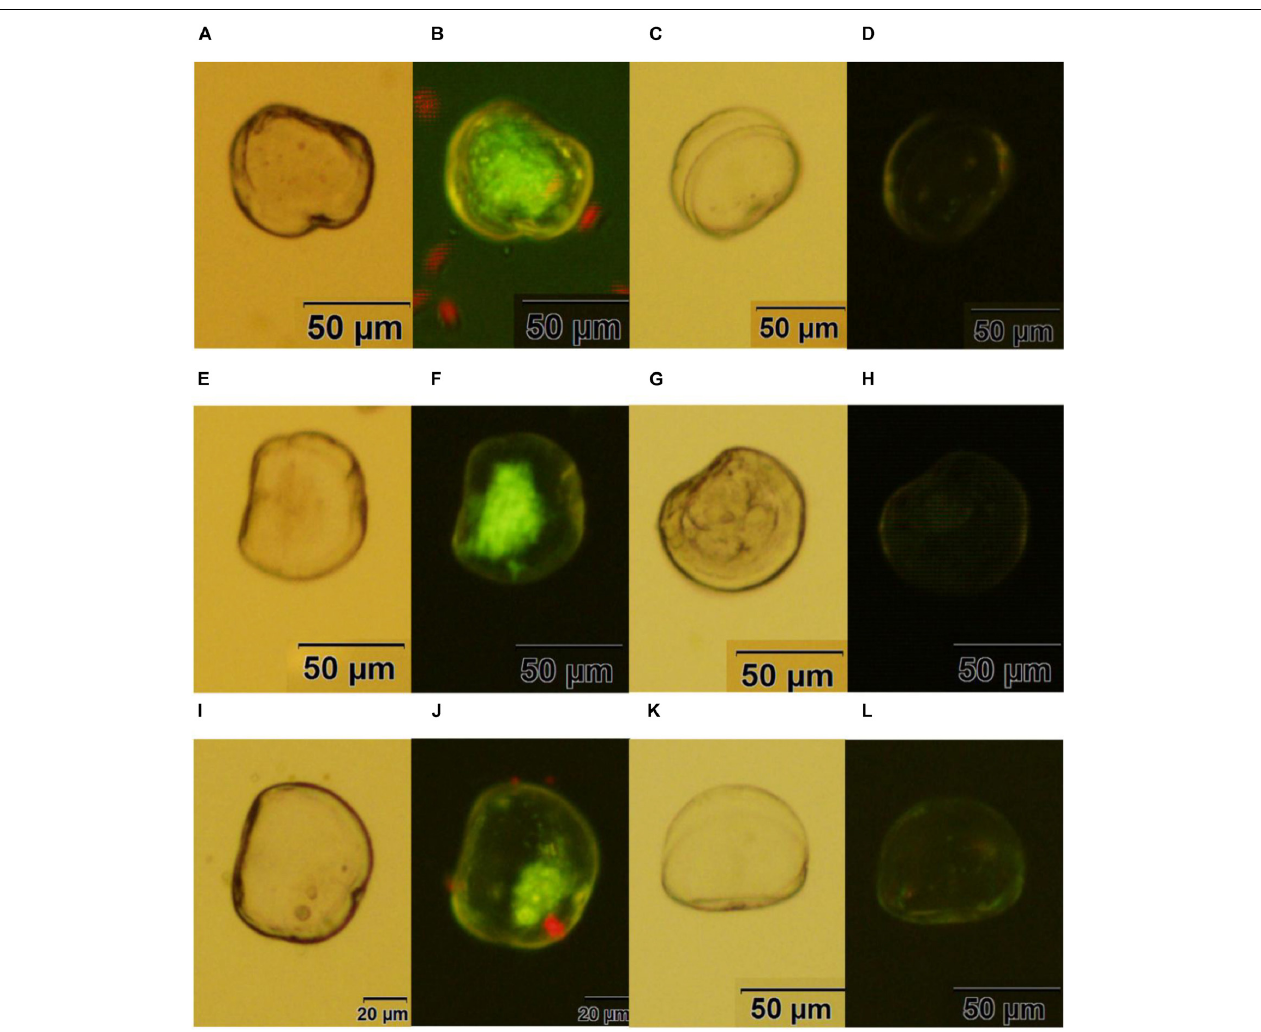
FIGURE 3 | Transgenic oyster larvae and controls. (A,B) Oyster larvae transfected with piggyBac using sperm mediation without electroporation under white light or green fluorescence; (C,D) non-transfected oyster larvae as a control for (A,B) ; (E,F) oyster larvae transfected with piggyBac using sperm mediation with electroporation under white light or green fluorescence; (G,H) non-transfected oyster larvae as a control for (E,F) ; (I,J) oyster larvae transfected with piggyBac-gGH using sperm mediation with electroporation under white light or green fluorescence; (K,L) non-transfected oyster larvae as a control for (I,J) Red spots are the algae Isochrysis galbana used as food for oyster